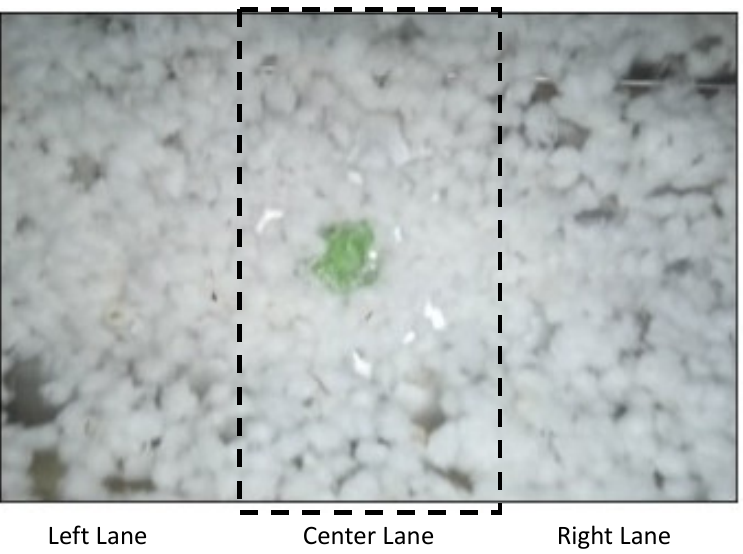
Figure 14. The flow chart for the solenoid firing loop.